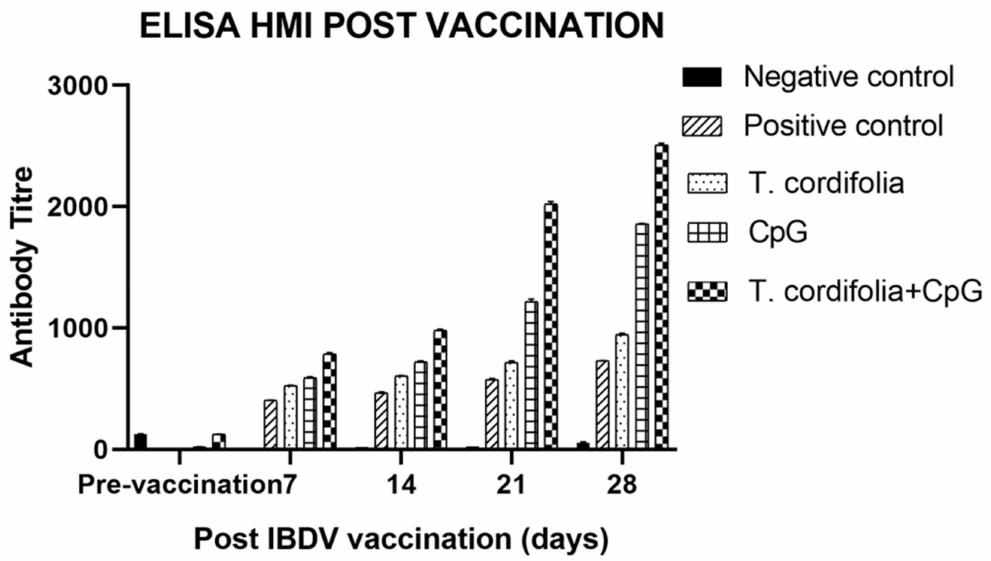
Figure 7. Serum antibody titer in chickens vaccinated with IBDV at di ff erent DPV by ELISA kit method. Antibody titer is expressed as mean ± SE of antilog of Log 10